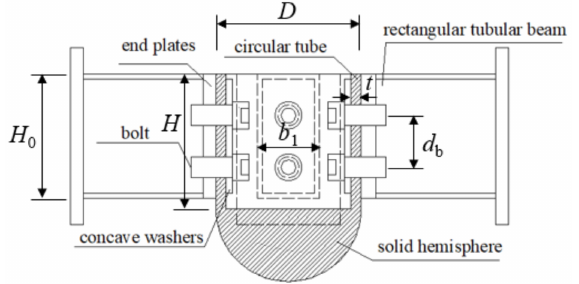
Figure 1. Bolted ball-cylinder